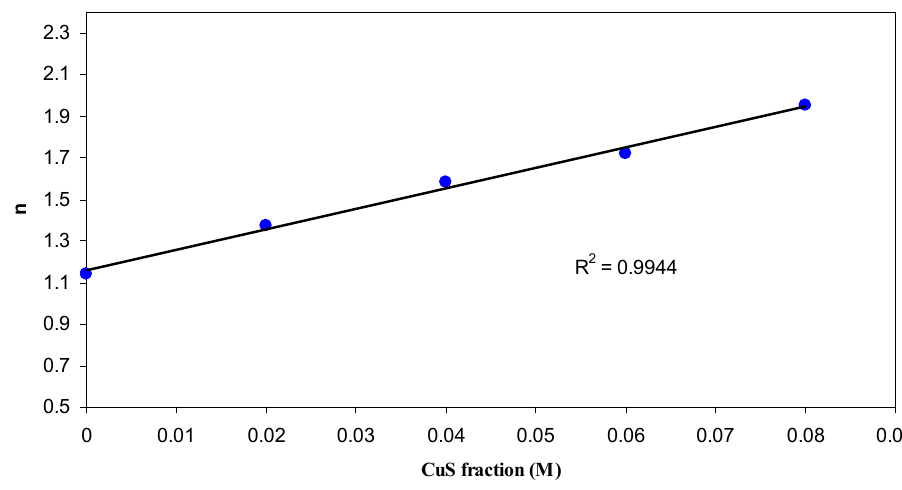
Figure 5. Refractive index of MC versus CuS fraction.